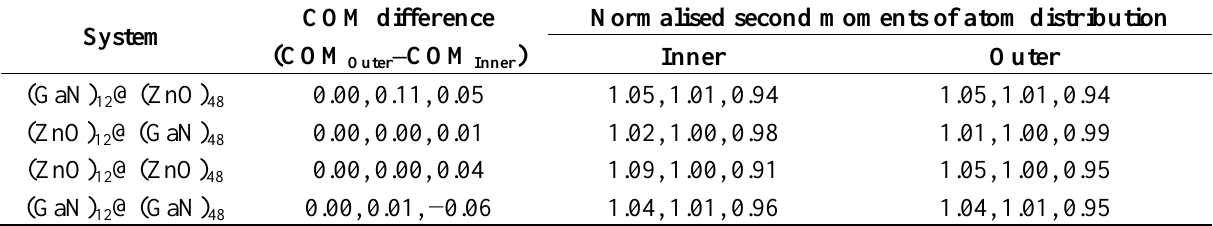
Table 2. Centre of mass (COM) differences and normalised second moments of atom distributions for the double bubble clusters ( x , y , z